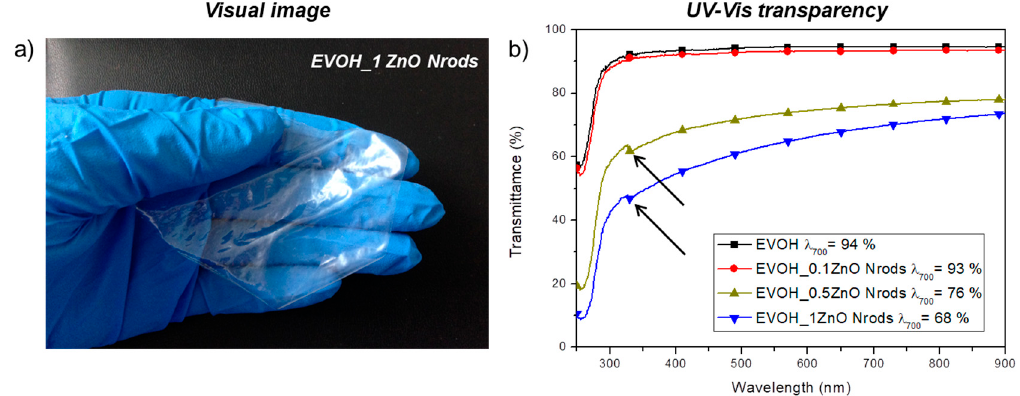
Figure 3. Visual images of poly(vinyl alcohol-co-ethylene) (EVOH)_1ZnO Nrods film ( a ) and UV-Vis analysis of EVOH-based formulations ( b ).